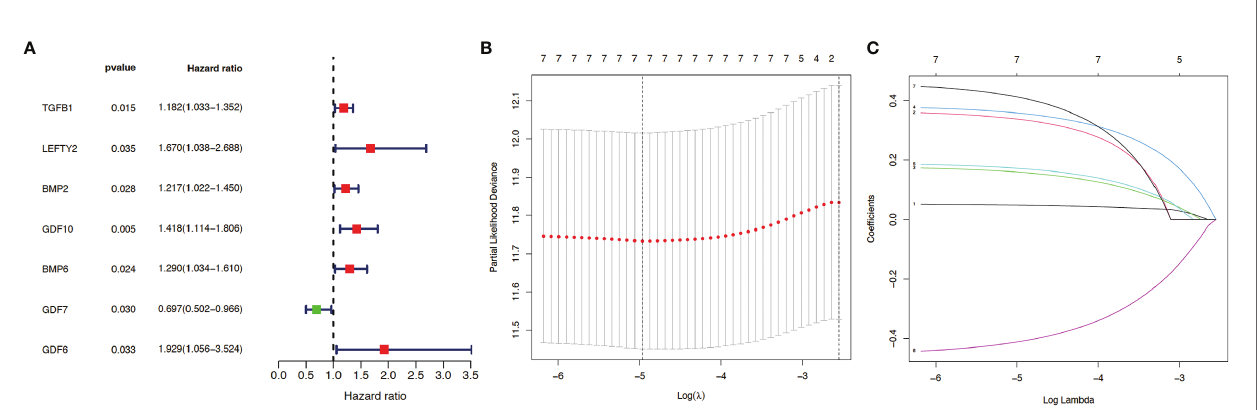
FIGURE 1 | Construction of prognosis model. Thirty-two genes from the TGF- b family were subjected to univariate Cox regression analysis. (A) Seven TGF- b family members (including TGF- b 1) were identi fi ed as independent prognostic factors for hepatocellular carcinoma (HCC) using survival, survminer, and forestplot packages. Red indicates positive correlation while green indicates negative correlation. p < 0.05 suggests statistical signi fi cance. LASSO regression analysis was applied to reduce model complexity and prevent over- fi tting, with the optimal lambda values shown in (B) As indicated in (C) , after analysis using glmnet and survival packages, each curve in the LASSO regression represents a gene, with the coef fi cients shown in the y -axis. The numbers on the top of (B, C) indicate how many genes are left in the model when Lambda is set to a certain value. The coef fi cients from top to bottom in (C) correspond to the respective genes as follows: GDF6